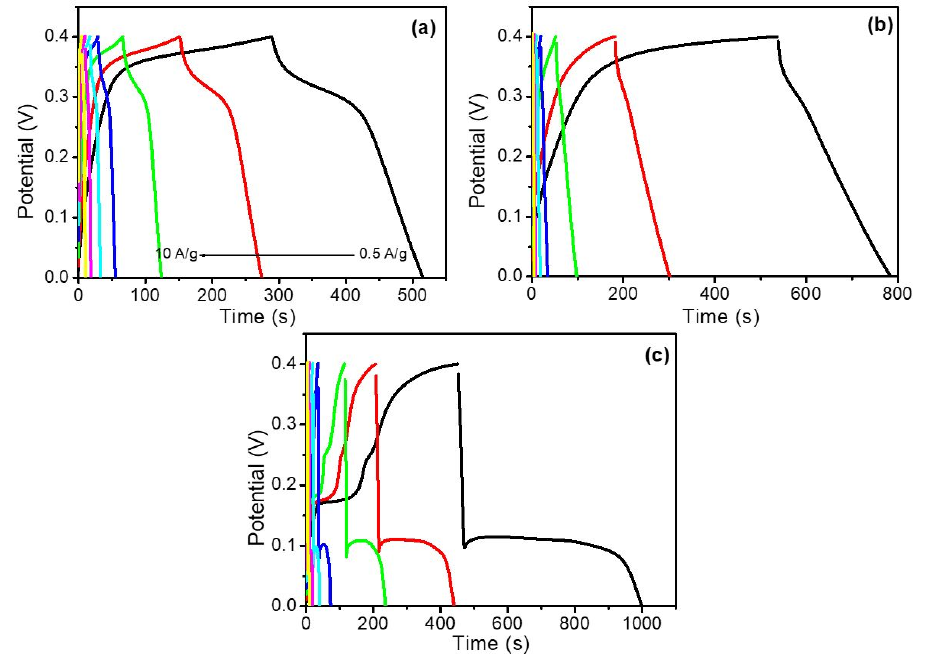
Figure 9. GCD curve of ( a ) pure MnO 2 rods, ( b ) rGO@MnO 2 , ( c ) Ag-rGO@MnO 2 at different current densities. Table 2. Capacitive values of MnO 2 rods, rGO@MnO 2 , and Ag-rGO@MnO 2 at different current den- sities.